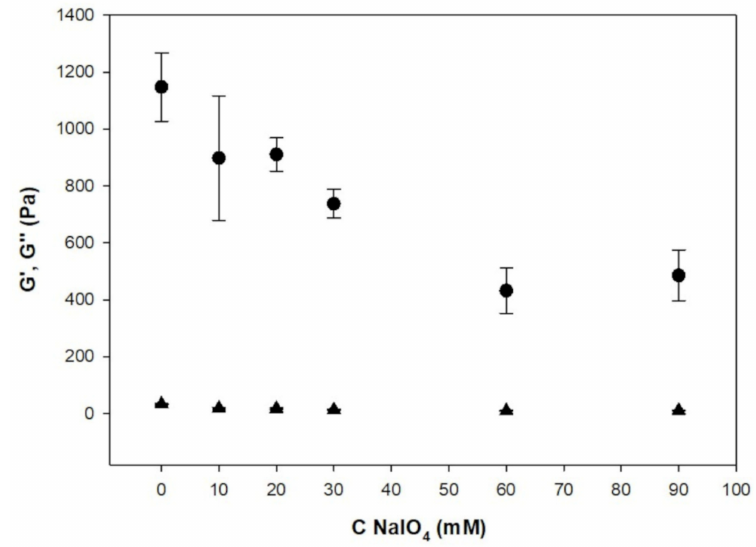
Figure 1. Final storage (circles) and loss moduli (triangles) of gelatin gels after 3 h of gelation as a function of the NaIO 4 concentration added to a gelatin sol at 10% w / v . The data correspond to the average over three independent measurements and the error bars to ± one standard